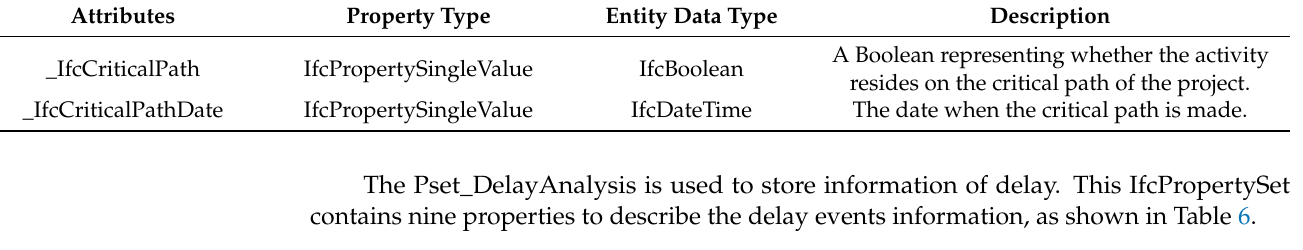
Table 6. Definition of the Pset_DelayAnalysis.